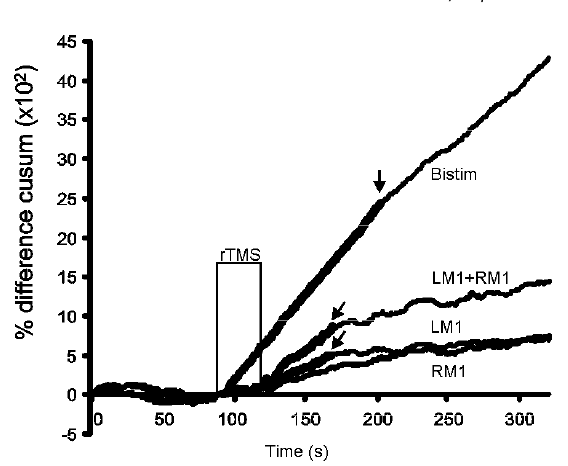
Fig. 5. Cumulative effects of simultaneous ipsilateral and contralat- eral rTMS on finger tapping. Average cumulative sum ( n = 7 ) of the percentage difference in peak force compared to baseline (effects of occipital stimulation subtracted). The tapping force became inap- propriately elevated after rTMS was delivered to LM1 from 8 s (95% confidence limits 1–21 s) to 51 s (43–63 s) after rTMS. RM1 stim- ulation did not elicit any significant change, and the algebraic sum of the effects of rTMS over the contralateral and ipsilateral motor cortices (LM1 + RM1) had the same onset and duration as the effect of contralateral stimulation alone. The effect of simultaneous bilat- eral stimulation of both motor cortices began during stimulation and continued until 86 s (69–102 s) after rTMS. Used with permission from Strens et al. 2004